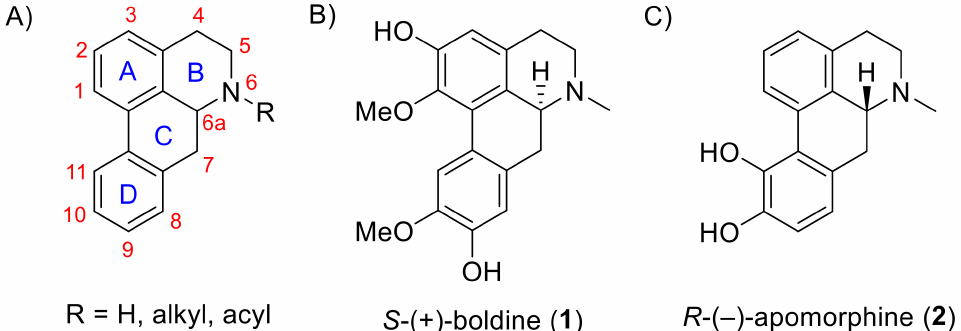
Figure 1. ( A ) Tetracyclic skeleton of aporphines with IUPAC numbering. ( B ) Structure of S -(+)-boldine ( 1 ). ( C ) Structure of R -( − )-apomorphine ( 2